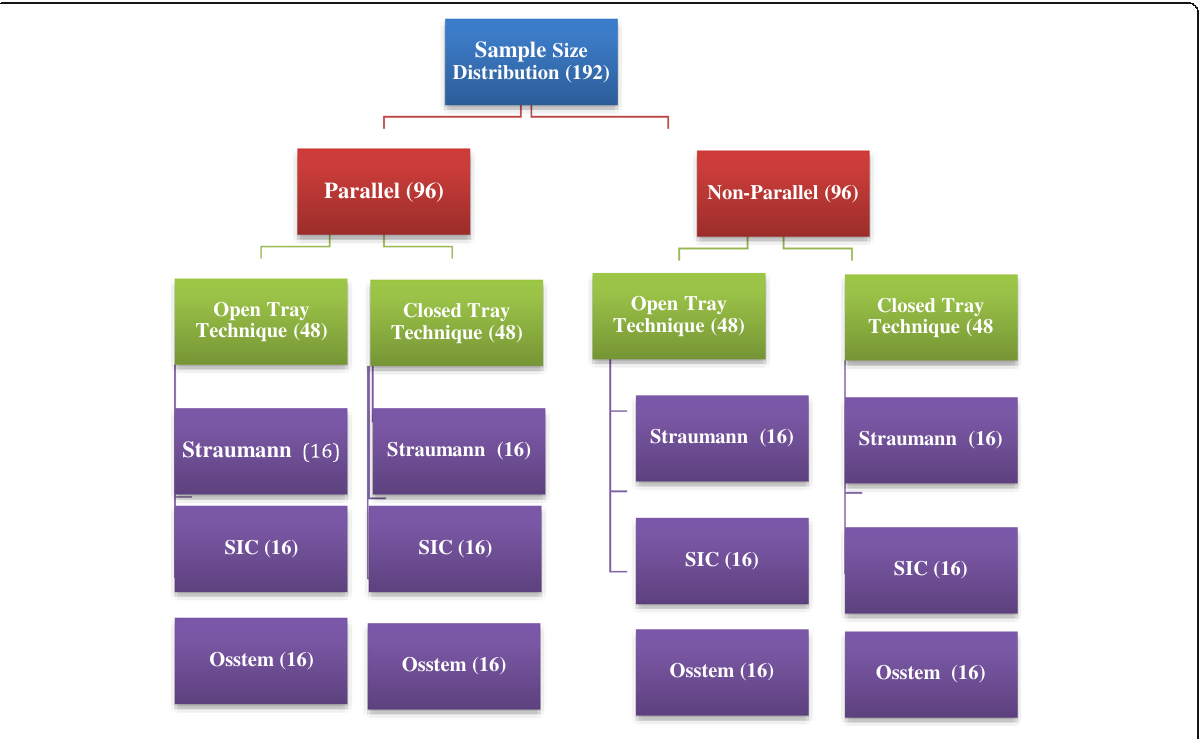
Fig. 1 Flowchart of the sample distribution